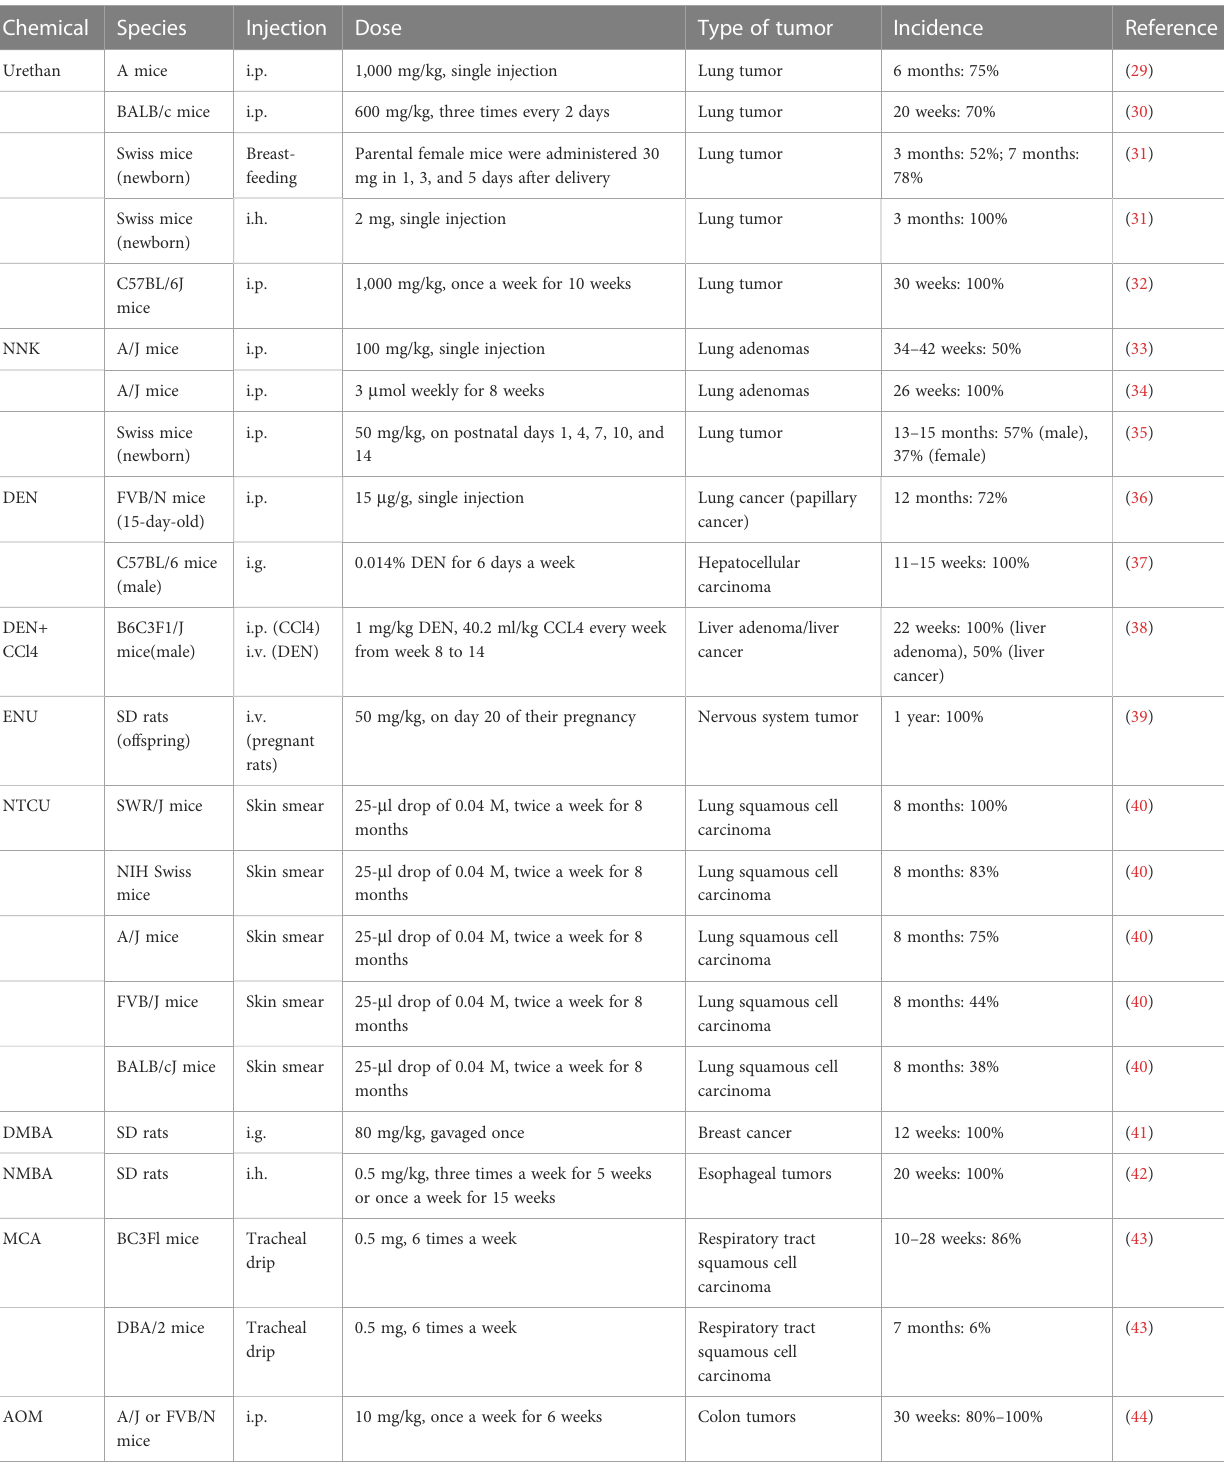
TABLE 1 Construction method of animal tumor model induced by chemical